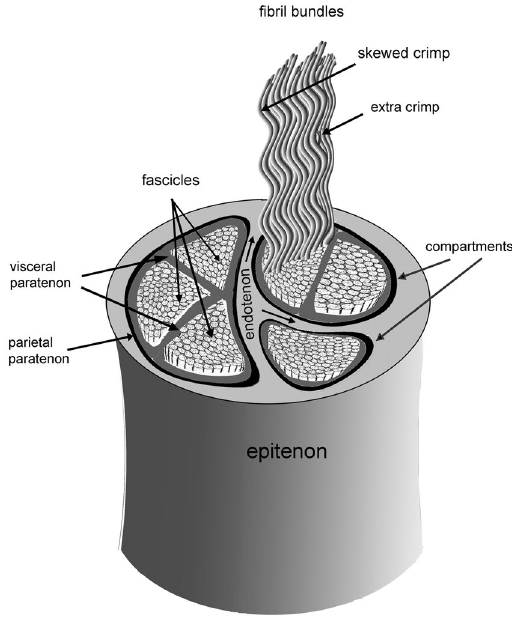
Figure 2. Rat tail tendon morphology: The outer epitenon is a dense interwoven sheath from which arise endotenons, which divide the interior of the tendon into compartments, each lined with a thin sheath, the parietal paratenon. Within each compartment are one or more fascicles, which consist of fibril bundles enclosed within a thin sheath called the visceral paratenon. Legend: light grey: endotenon, black: parietal paratenon, dark grey: visceral